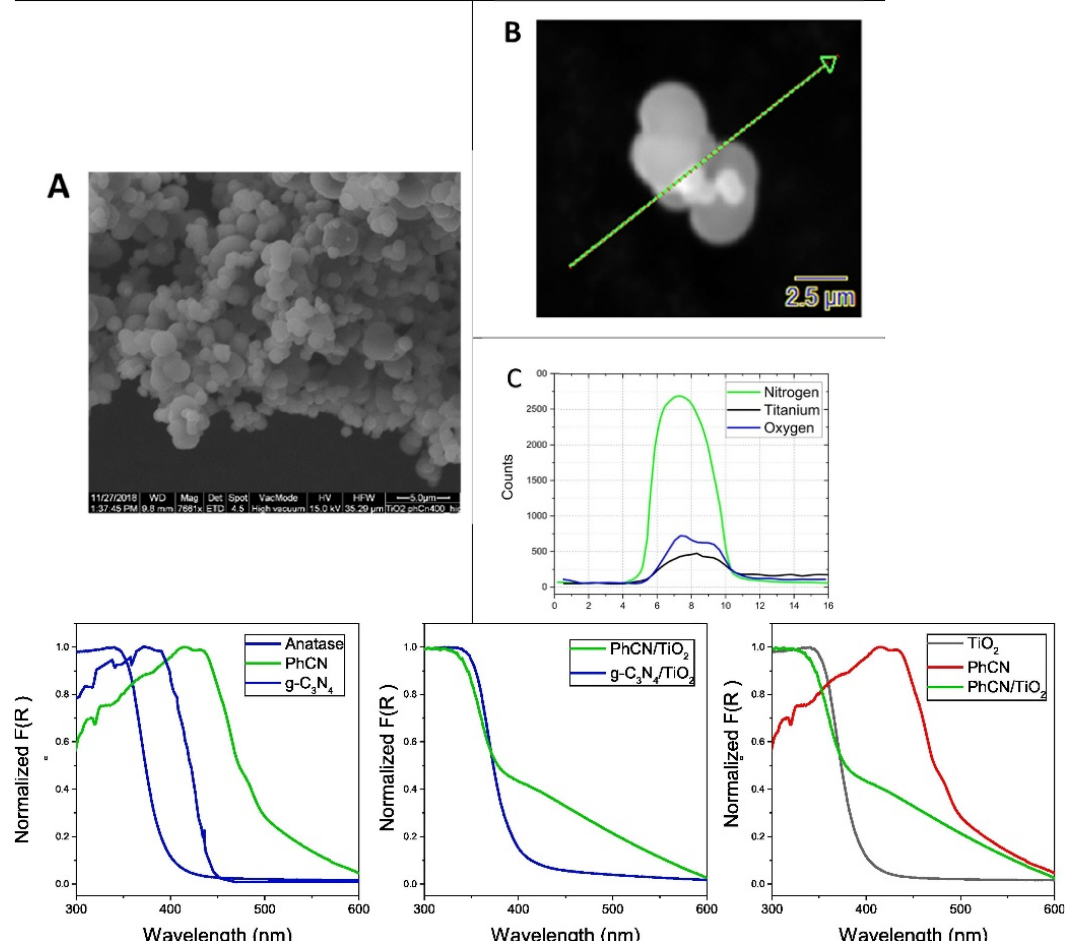
Figure 13. SEM images of PhCN/TiO 2 hybrid system taken at low ( A ) and high magnification ( B ) and EDX analysis for the cross-section denoted by the dashed green. Normalized absorption spectra of TiO 2 (anatase), g-C 3 N 4 , and PhCN (i.e., the building blocks for the hybrid systems) ( A ), the hybrid systems g-C 3 N 4 /TiO 2 and PhCN/TiO 2 ( B ), and the differential absorption of PhCN/TiO 2 from building blocks ( C ) [166].